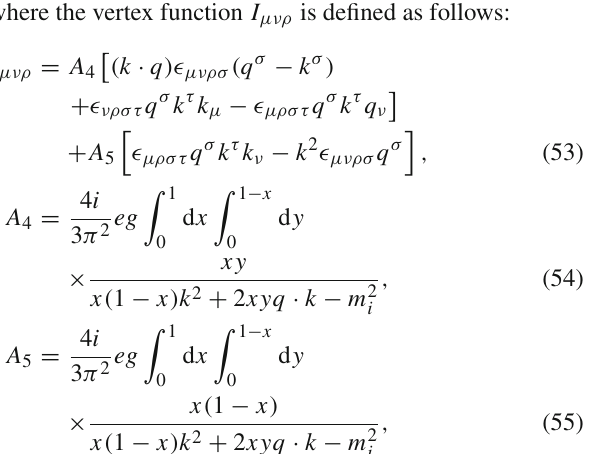
Fig. 5 Annihilation diagrams by tree and penguin operators. There are no hard gluons for these cases because they belong to the four Fermi interactions and do not include the spectator